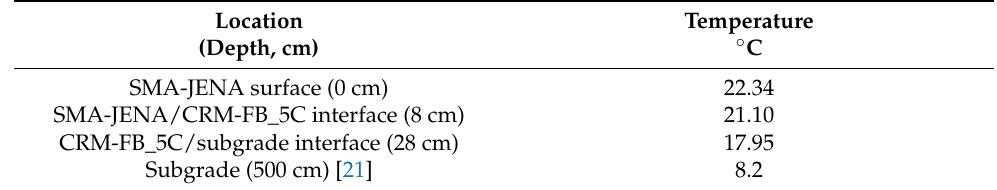
Table 8. Temperatures read from the monitoring system (boundary conditions).